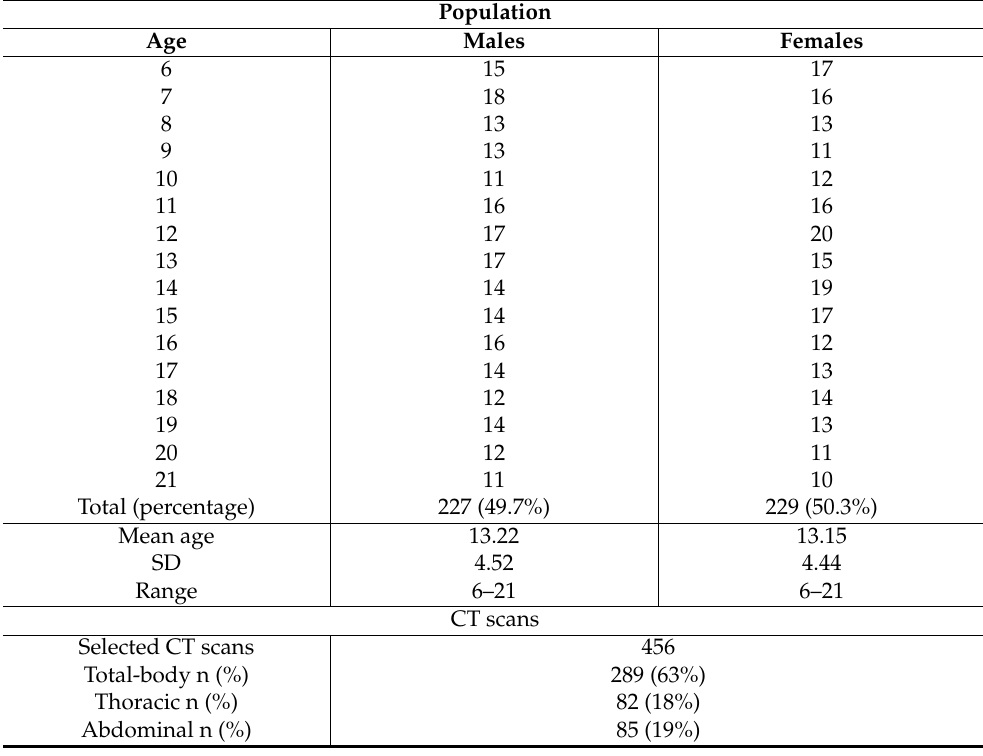
Table 1. Patient